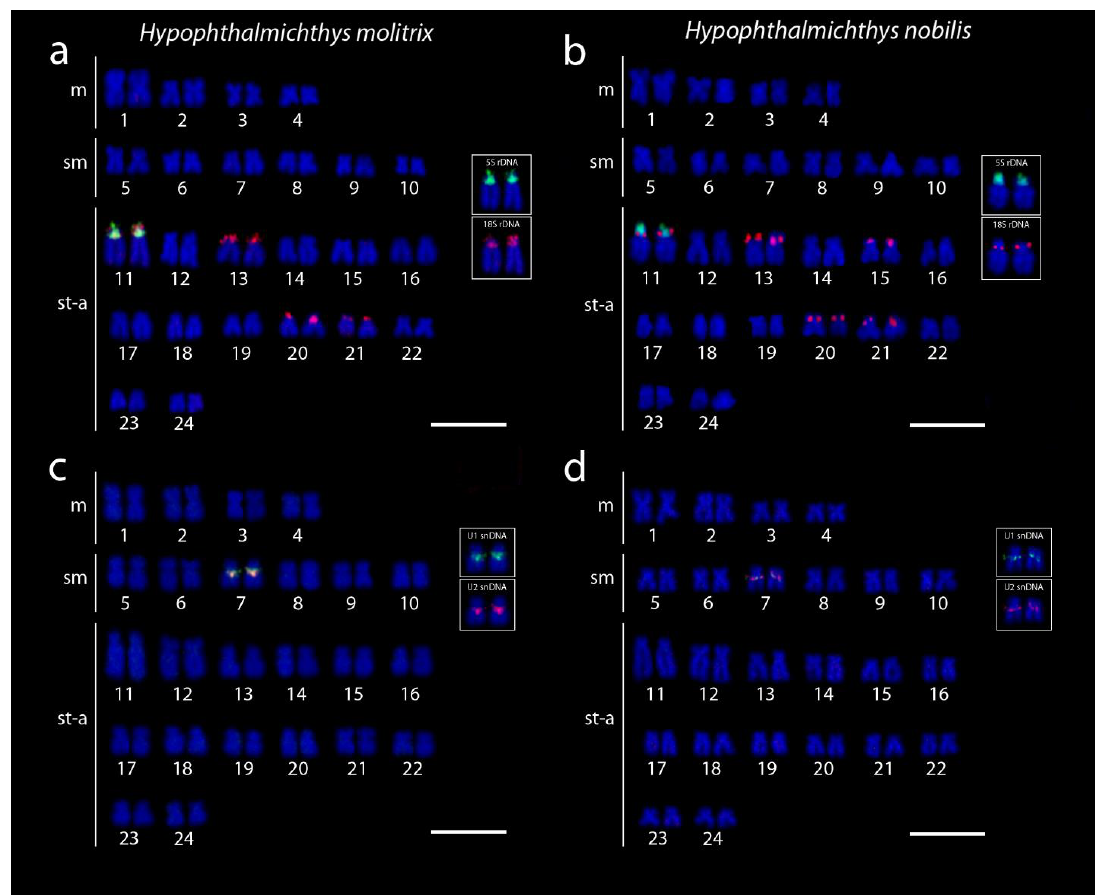
Figure 3. Karyotypes of Hypophthalmichthys molitrix and H. nobilis arranged after 5S/18S rDNA and U1/U2 snDNA FISH. ( a , b ) 18S rDNA (red) and 5S rDNA (green) probes. Insets show separately 5S and 18S rDNA signals on the largest acrocentric pair. Note the adjacent position of 5S and 18S rDNA signals on chromosome pair No. 11 in both species. ( c , d ) U1 (green) and U2 (red) snDNA probes mapped on mitotic chromosomes of ( c ) H. molitrix and ( d ) H. nobilis . Note the co-localization of a single pair of U1 and U2 snDNA signals in small sm chromosome pair No. 7. Insets show separate hybridization signals for each individual probe. Chromosomes were counterstained with DAPI (blue). Identification codes of individuals: ( a ) H, molitrix HM2, ( b ) H. nobilis HN1, ( c ) H. molitrix HM4, and ( d ) H. nobilis HN3. Scale bar = 10 µm.